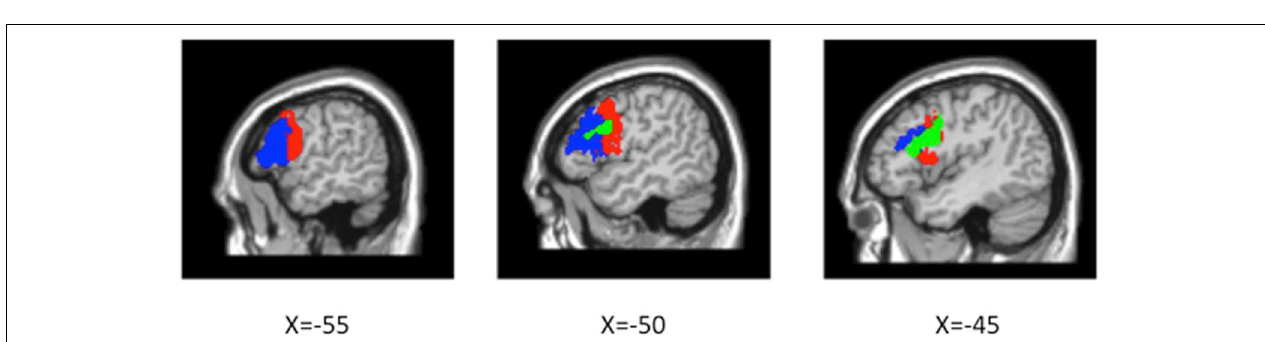
surface of the brain. The histogram to the right presents the mean percent signal change + s.e.m. over the entire cluster broken down by condition (percent signal change was calculated in Marsbar per subject).